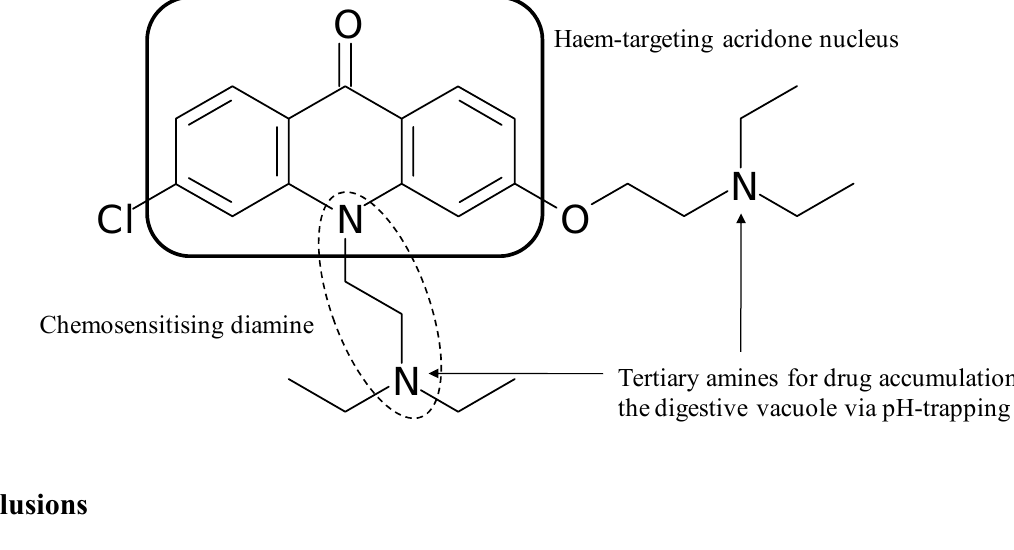
Figure 9. Acridone derivative T3.5, highlighting the haem-targeting nucleus overlapping the chemosensitising diamine moiety. Redrawn based on the original reference